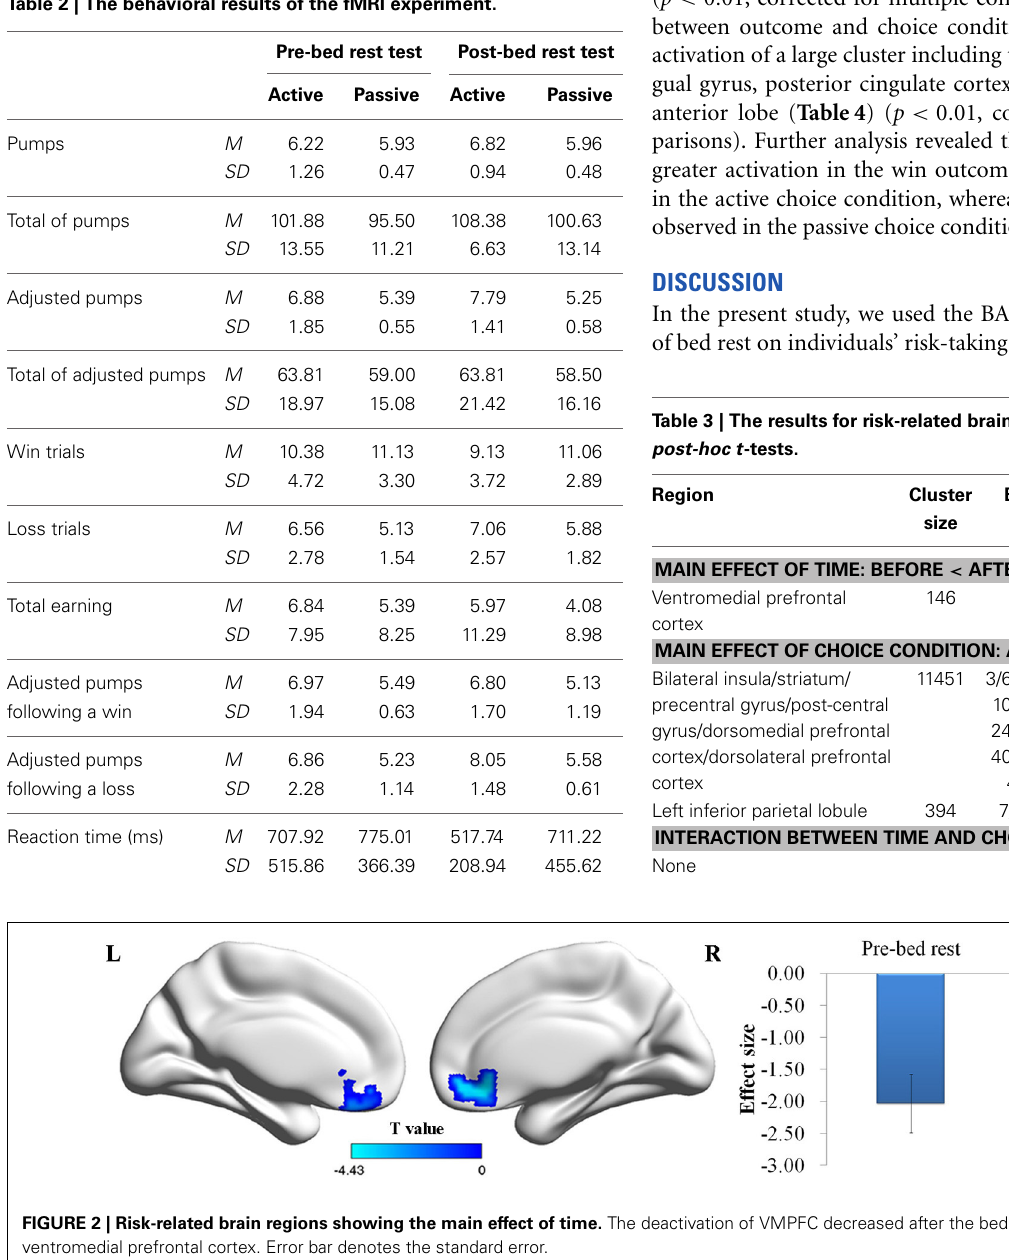
Frontiers in Behavioral